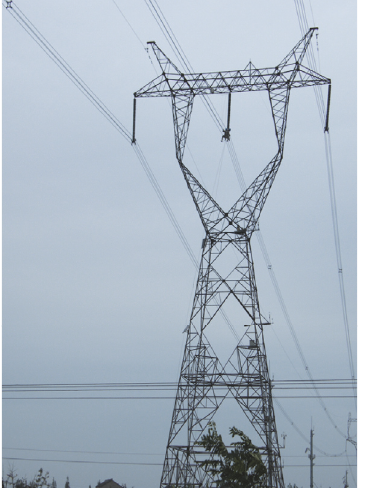
Figure 1: A high-voltage transmission tower-line system (tower number 160).